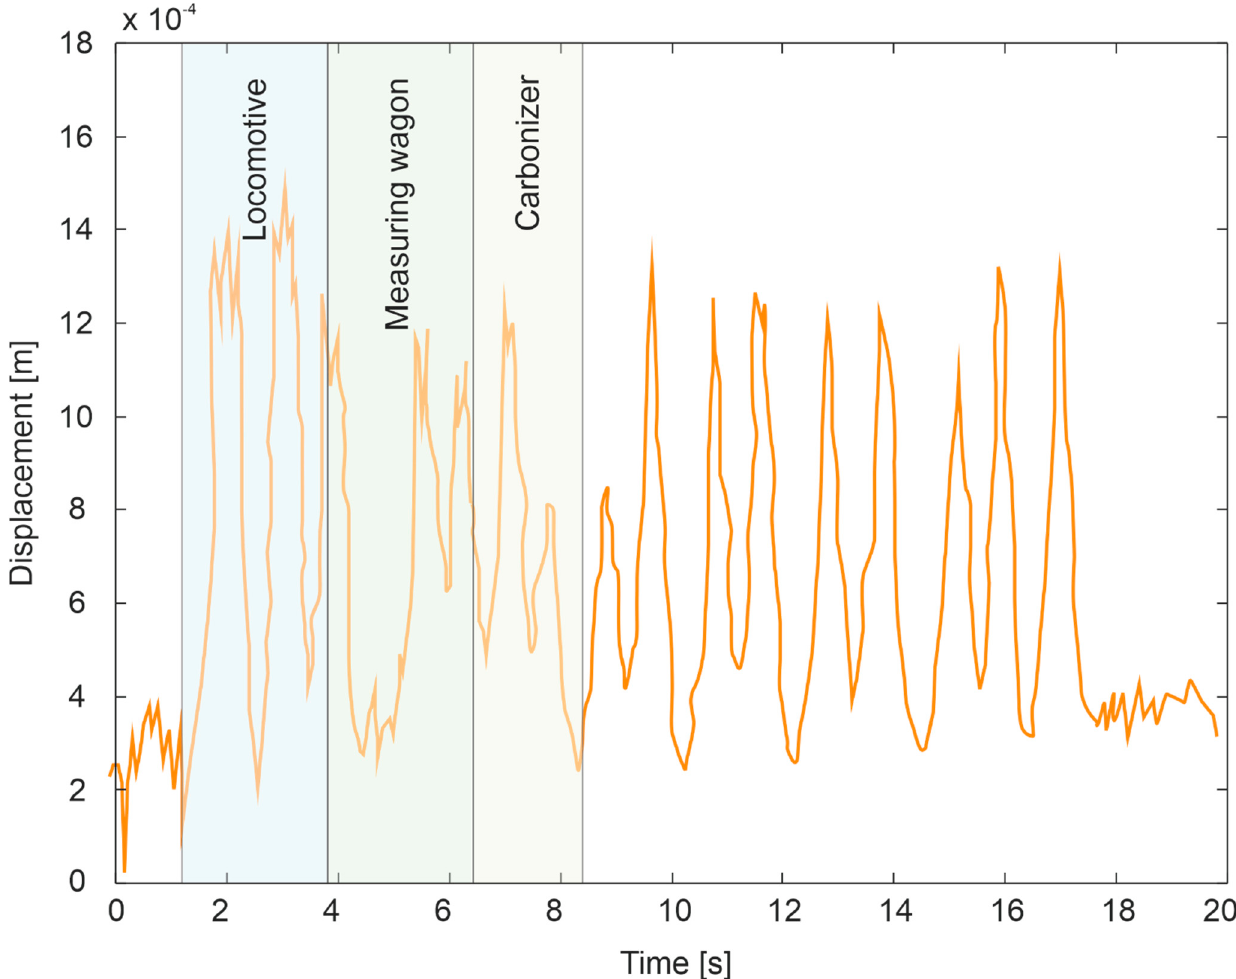
Figure 3. Example of track deflection. Five runs were made, resulting in five deflections at each measurement point. Mean deflection values and standard deviation were determined for these quantities. These results are shown in Table 2.